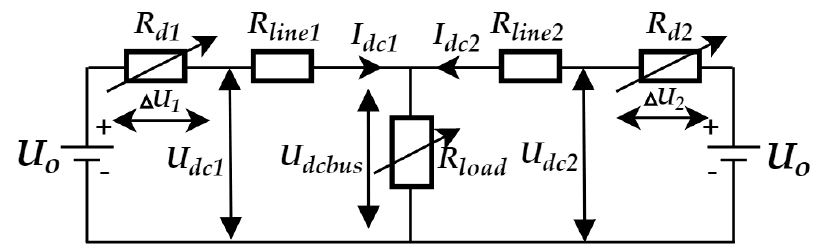
Figure 12. The diagram of DC microgrid.